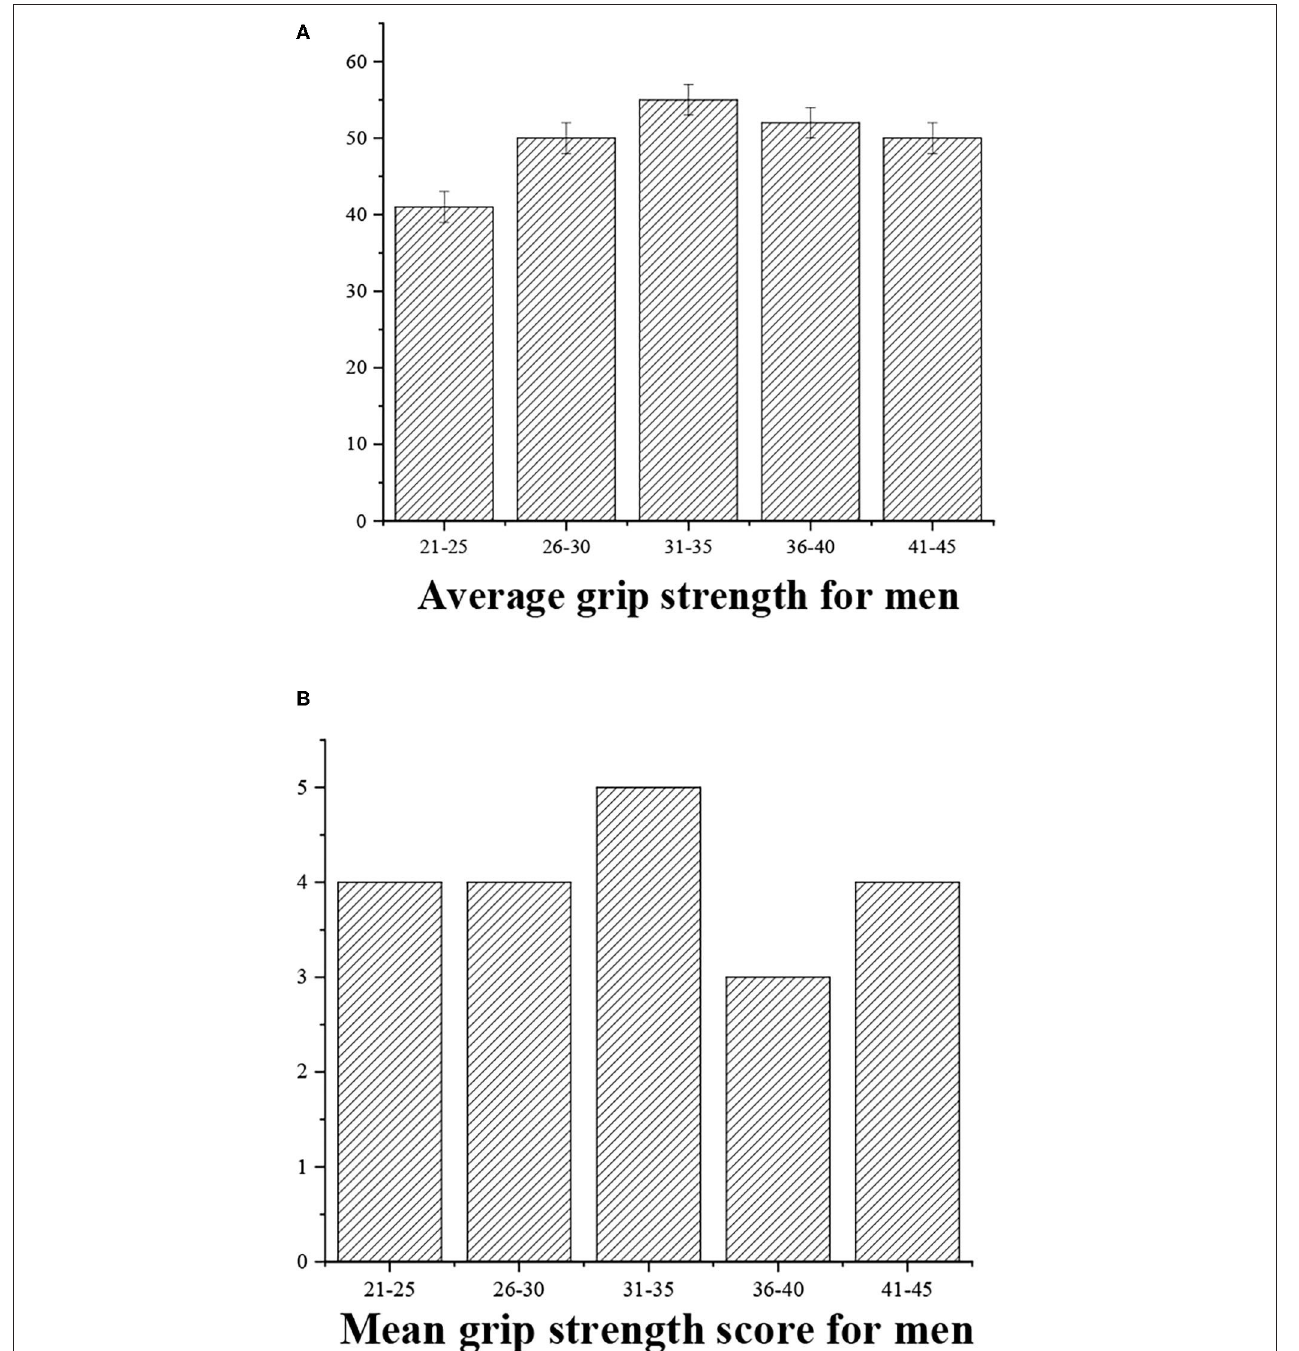
FIGURE 6 | (A) Statistical average grip strength for men of different ages. (B) Grip strength score.